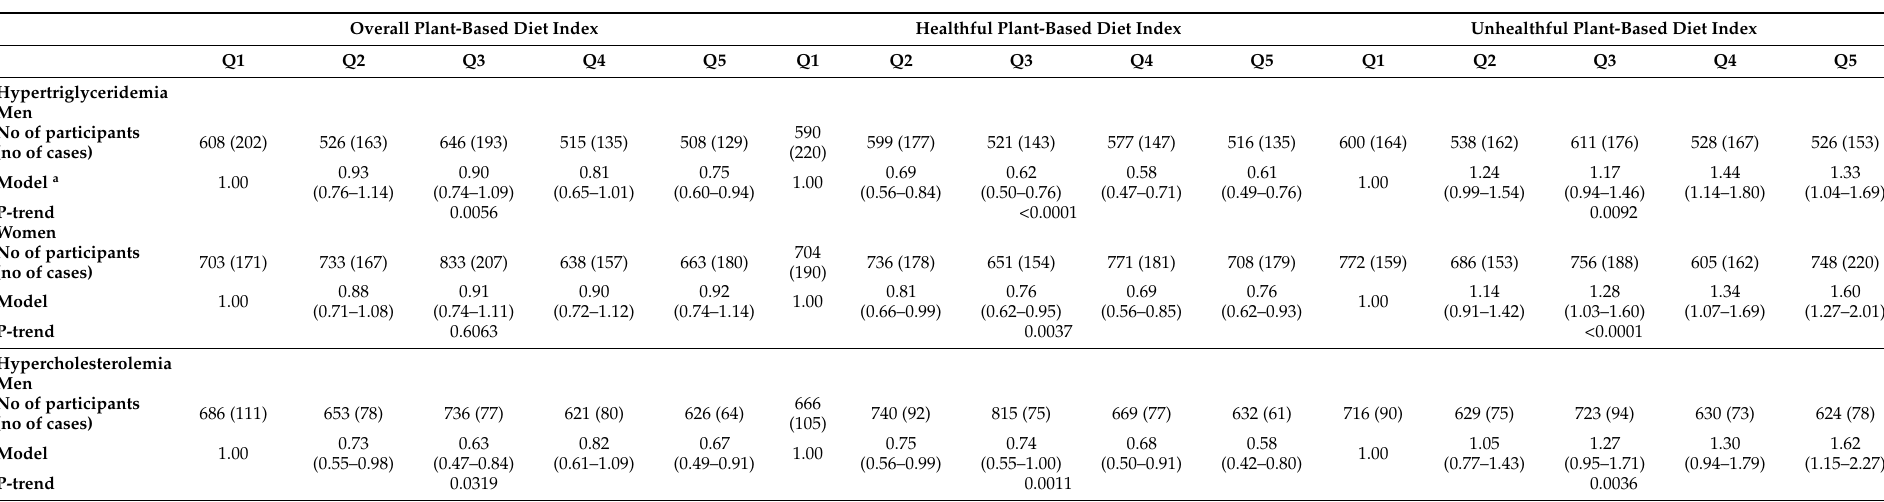
Table 3. Hazard ratios (HRs) and 95% confidence intervals (CIs) for individual lipid disorders according to quintiles of plant-based diet scores among Korean